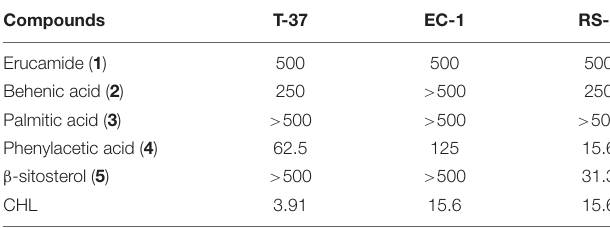
TABLE 1 | The minimum inhibitory concentration ( µ g/mL) of the compounds. Compounds T-37 EC-1 RS-2 Erucamide ( 1 ) 500 500 500 Behenic acid ( 2 )